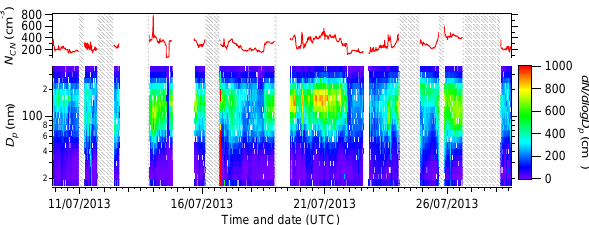
Figure 4. The time series of total particle counts (integrated from size distributions; top panel) and particle number size distribution (bottom panel). Shaded areas represent pollution episodes removed from the data. Any other gaps are due to instrument downtime.